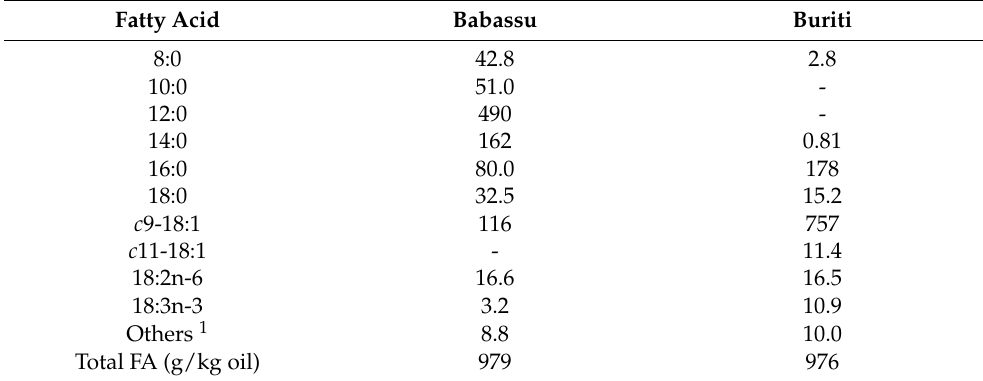
Table 2. Fatty acid profile (g/kg total FA) of babassu oil and buriti oil. Fatty Acid